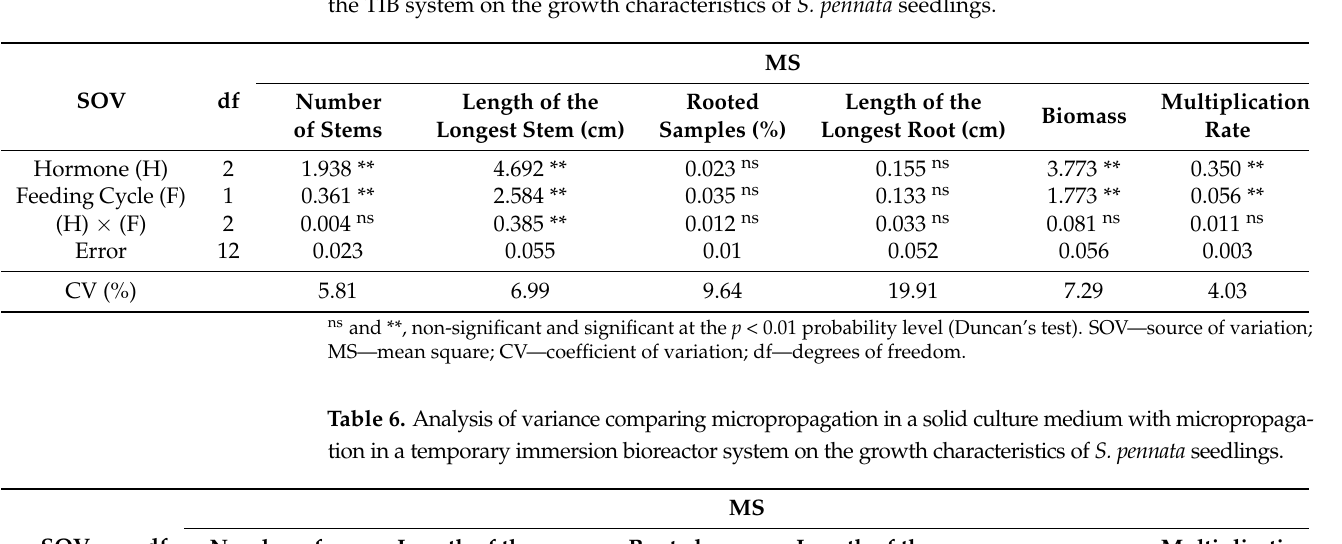
Table 5. Analysis of variance of plant growth hormones effect and the number of feeding cycles in the TIB system on the growth characteristics of S. pennata seedlings.